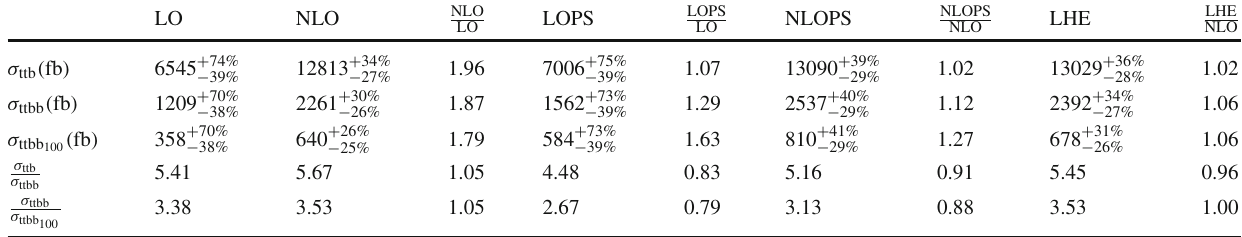
√ Table 1 Cross sections for pp → t ¯ tb ¯ b at s =13TeV and their ratios to corresponding LOPS and NLOPS predictions of Powheg+Pythia in the phase space regions with N b ≥ 1 (ttb) and N b ≥ 2 (ttbb) b -jets as > 100GeV of the ttbb phase space (ttbb well in the region m b 100 ). 1 b 2 Nominalfixed-orderpredictionsatLOandNLOaccuracyarecompared